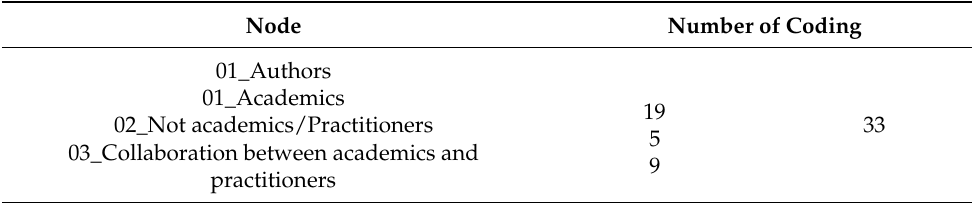
Table 2. Coding framework and